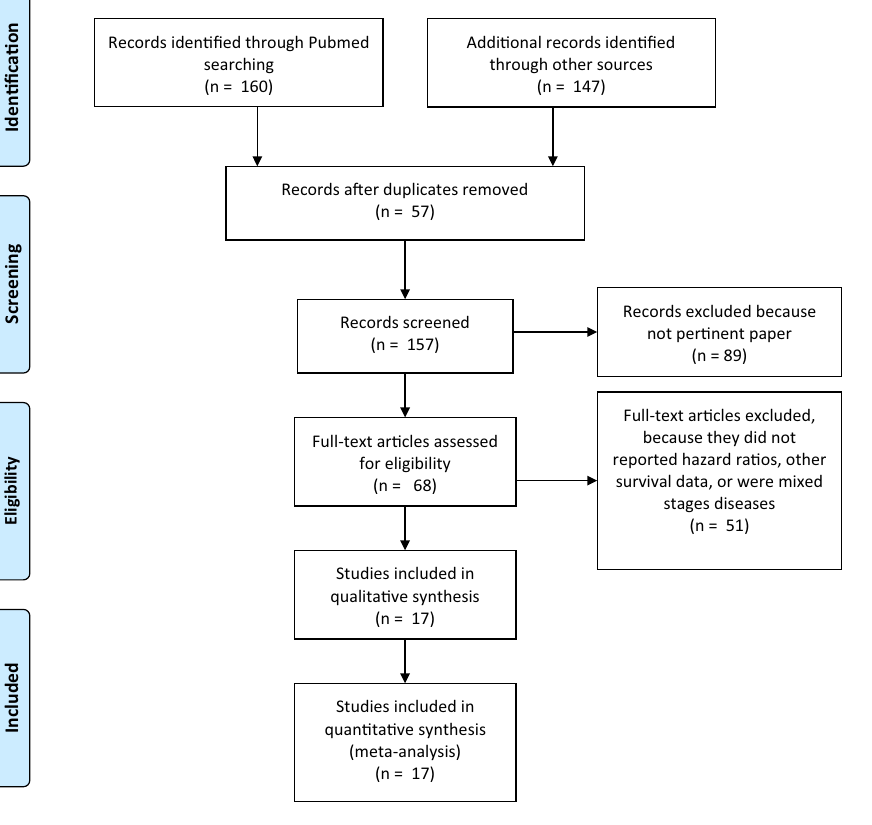
Figure 1. Flow diagram of included